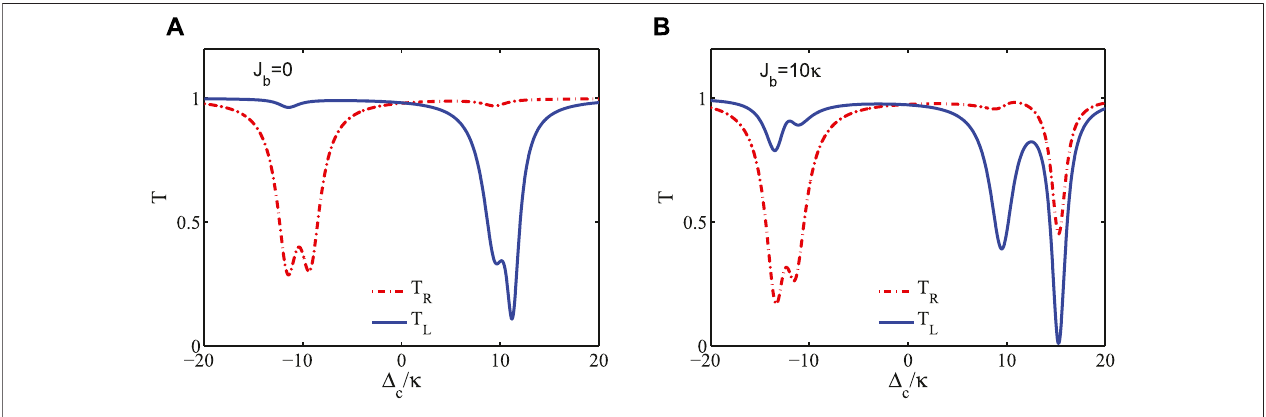
FIGURE6| (Coloronline) Thetransmissionrates T R and T L versusthedetuning Δ c / κ for (A) J b =0and (B) J b =10 κ . Theparameters areset as: κ =5×10 − 3 ω c , Ω = 0.97 GHz, κ i